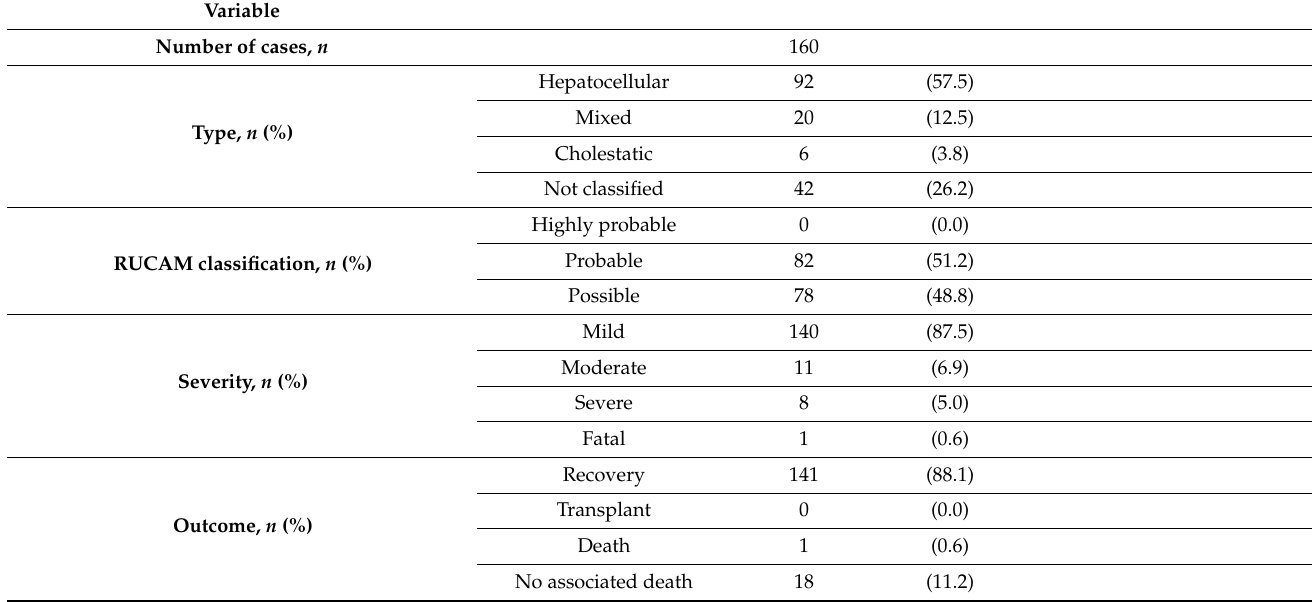
Table 3. Characteristics of DILI